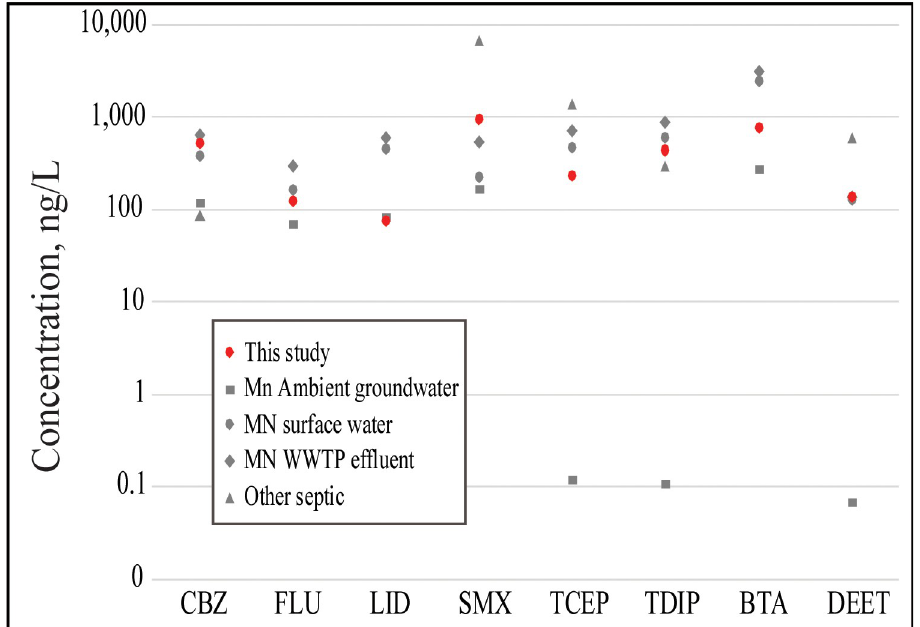
Fig 3. Comparison of maximum concentrations of most frequently detected ( � 30%) micropollutants in this study and Minnesota (MN) ambient groundwater [9], MN surface water [6], MN wastewater treatment plant (WWTP) effluent [6], and other septic systems [7]. CBZ, carbamazepine; FLU, fluconazole; LID, lidocaine; SMX, sulfamethoxazole; TCEP, tris(2-chloroethyl) phosphate; TDIP, tris(dichloroisopropyl) phosphate; BTA, methyl-1H- benzotriazole; DEET, N , N -diethyl-meta-toluamide.